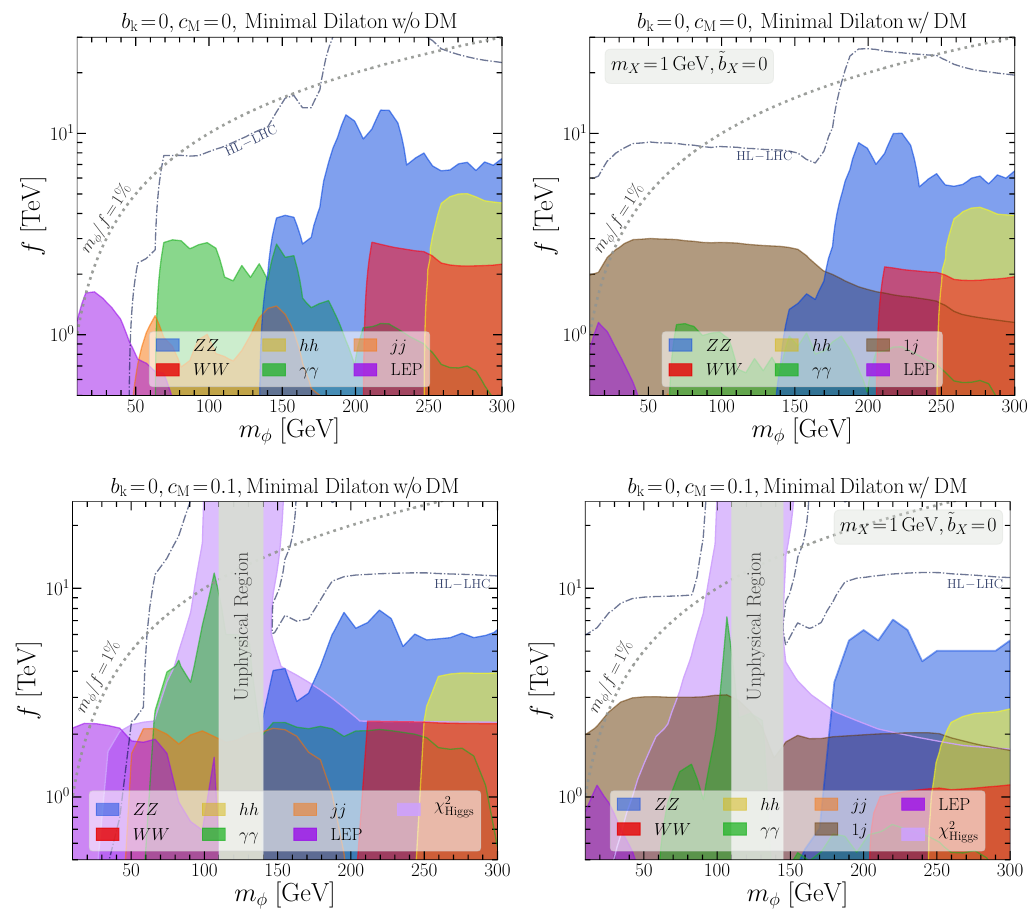
Figure 3 . The upper (lower) plots show the exclusion bound on the minimal dilaton parameter space in the m (cid:30) vs f plane with the mass mixing parameter c = 0 (0 : 1). The color coded legends m correspond to di(cid:11)erent exclusions bounds from the LHC and LEP experiments, see text. The left-panel and right-panel shows the constraints without and with the portal to the dark sector, respectively. The gray band in the lower-panel plots corresponds to the unphysical